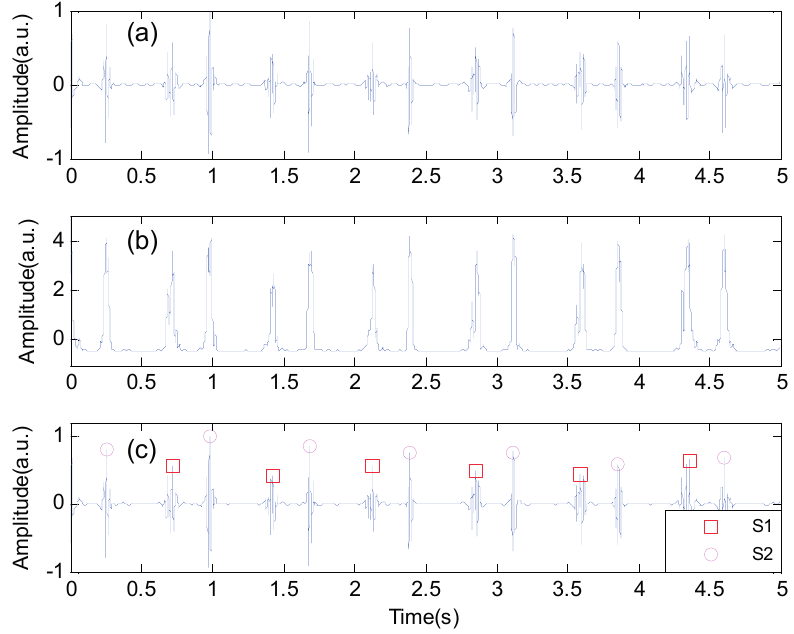
Figure 3. Identification of the second heart sound using the Shannon energy envelope. ( a ) The normalized heart sound signal; ( b ) The normalized average Shannon energy; ( c ) The first heart sounds and the second heart sounds marked with squares and circles,